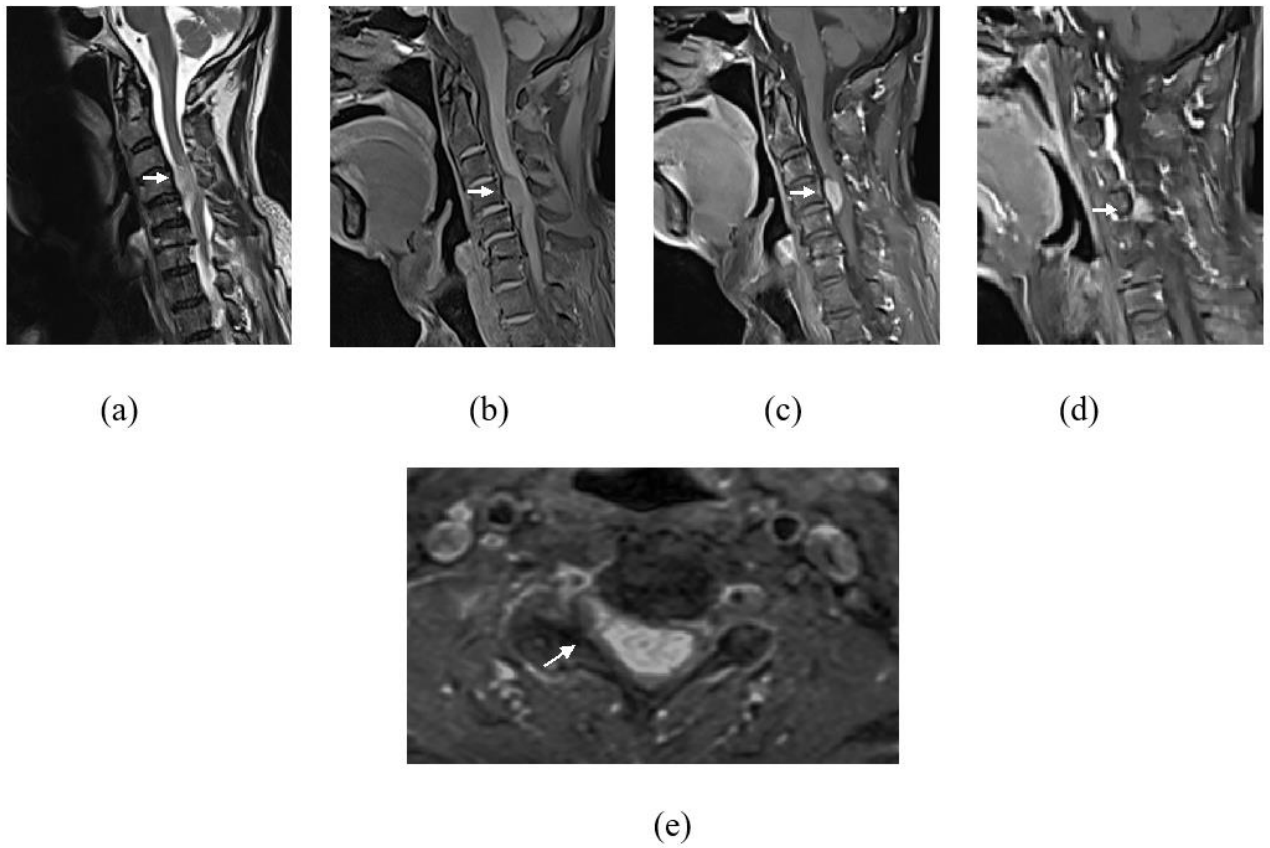
Figure 2. Images of cervical spine showing an intradural extramedullary lesion (white arrow) at the level of C4–C5. It demonstrates hyperintense signal on T2WI ( a ), intermediate signal on T1WI ( b ) and avid enhancement on gadolinum-T1FS sequence ( c , e ). This lesion causes spinal cord compression at this level with associated spinal cord T2WI hyperintense signal indicating of cord oedema ( a ). Right parasagittal image ( d ) showed extension into the right C4 neural foramina ( e ).